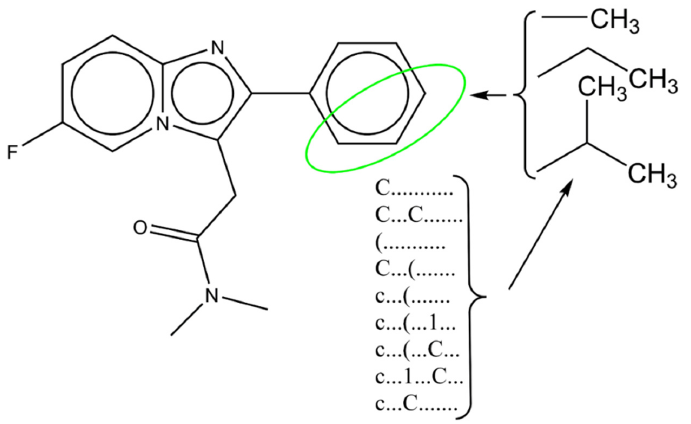
Figure 3. Schematics for computer—aided drug design. As a template molecule (A), one of the least chemically exploited molecules from the original dataset (molecule 3) was chosen. After examination of the molecules dataset, observation was made that the phenyl group is the least chemically modified, so CAD was focused on the addition of simple aliphatic groups in ortho, meta, and para positions.